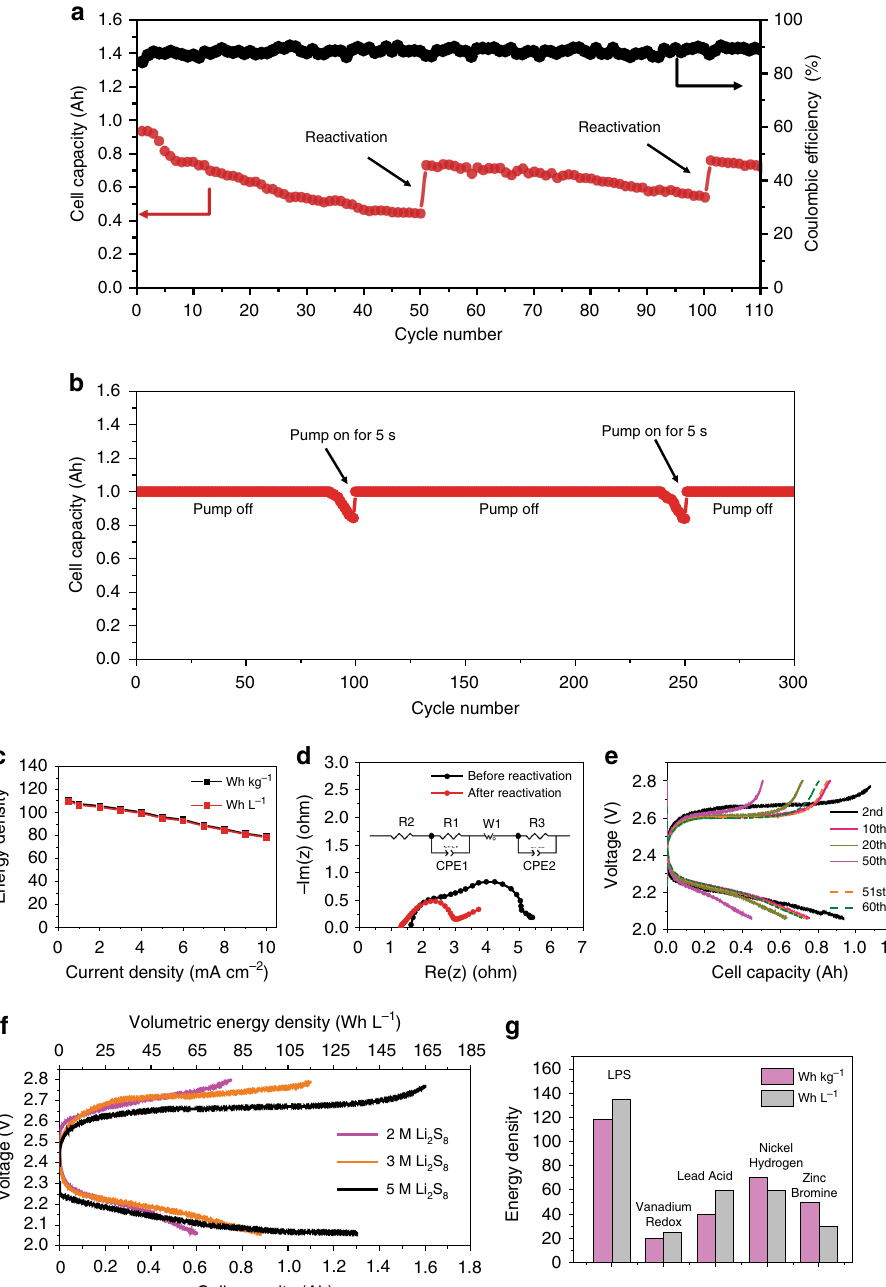
Fig. 4 Electrochemical characterization of LPS battery. a Cell capacity and Coulombic ef fi ciency of single LPS battery during 110 cycles (reactivation was conducted every 50 cycles). b Constant capacity cycling of LPS fl ow battery system (recipe of LPS fl ow battery system can be seen in Supplementary Tables 5 and 6). The charge capacity is set to 1000 mAh and the discharge cutoff voltage is set to 2.06 V. c Gravimetric and volumetric energy density at different current densities. d EIS measurement of LPS battery before and after reactivation (Inset Equivalent circuit diagram of LPS battery). e Voltage pro fi les and the corresponding cell capacity before and after reactivation. f Voltage pro fi les and their corresponding cell capacity and volumetric energy density for different concentrations of Li 2 S 8 . (2 and 3 M with pure carbon felt and 5 M with activated carbon felt, which has higher surface area for active materials trapping, as the current collector). g Gravimetric and volumetric energy density comparison between different batteries designed and used